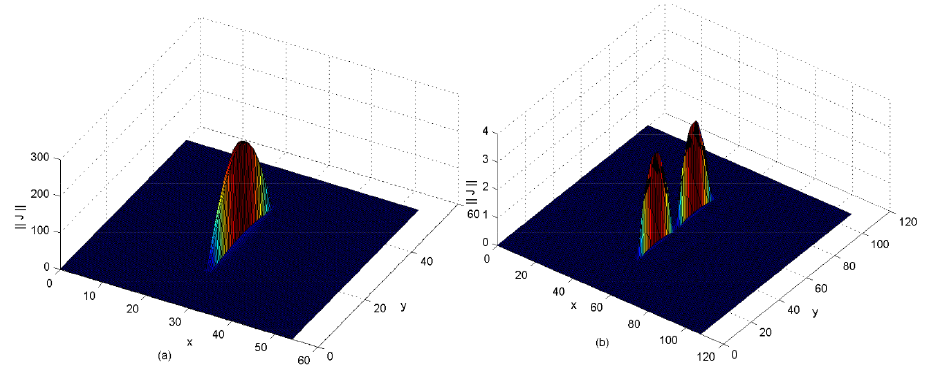
Figure 6. Current density for a unit cell of an almost periodic 2D array (half-wave and full-wave dipoles) defined over the guide aperture, described by the test functions using: f = 5.4 GHz, α 0 = 0 rad m − 1 , β 0 = 0 rad m − 1 , w = 1 mm, δ = 0.75 mm ( w (cid:28) λ 0 , δ (cid:28) λ 0 ) , d x = 108 mm, ≈ 27 mm; ( b ) L = λ ≈ 54 mm, h = 1.25 mm and (cid:101) = (cid:101) r = 1 and d y = 108 mm. ( a ) L = λ 0 0 2 (air) (see [1] for a comparison).